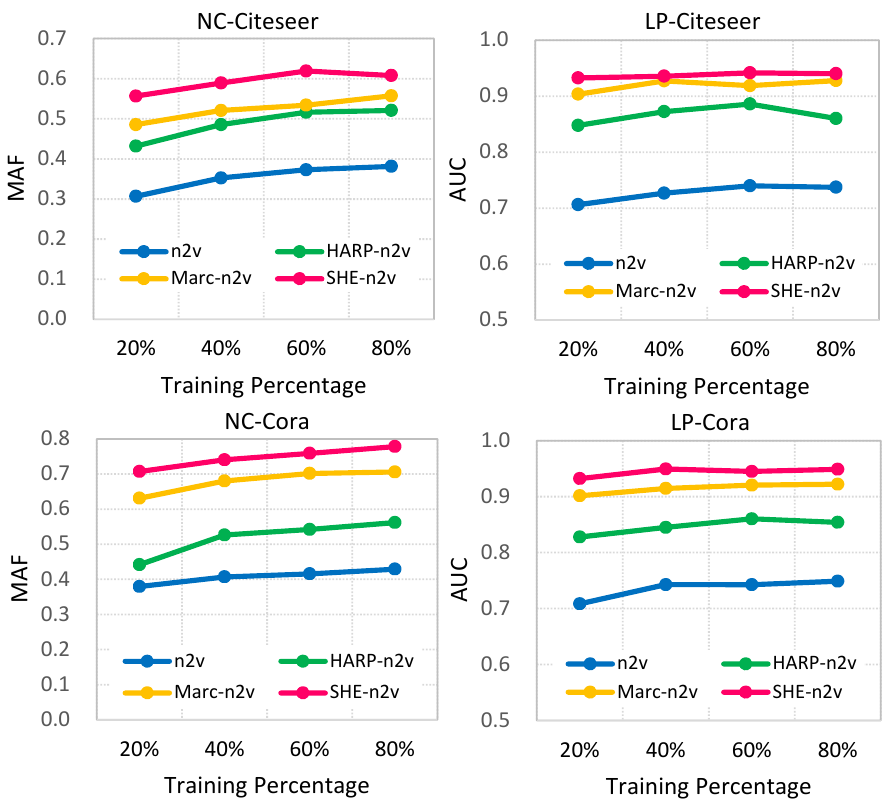
Figure 4. Results on node2vec (n2v) by varying the training percentage. The left and right columns are on node classification and link prediction, respectively. The top and bottom rows are using Citeseer and Cora datasets, respectively.